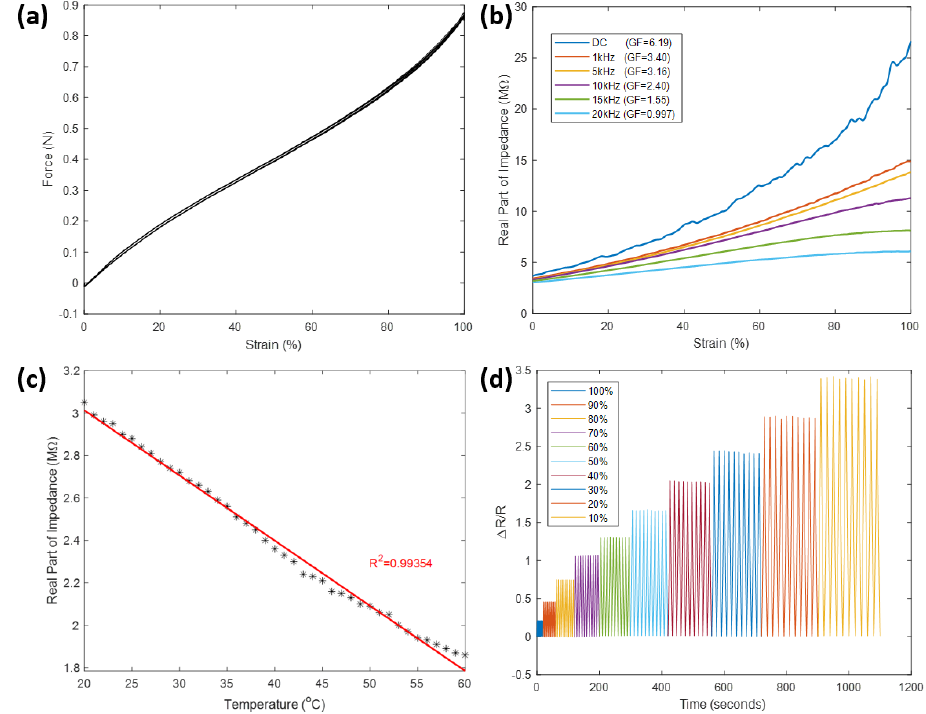
Figure 4. Characteristics of the strain sensor. ( a ): Force-strain relation determined by the mechanical tensile test. ( b ): Sensitivity variation due to the effect of the excitation frequency. ( c ): Resistance variation due to the effect of ambient temperature. ( d ): Relative change in resistance in the cyclic loading